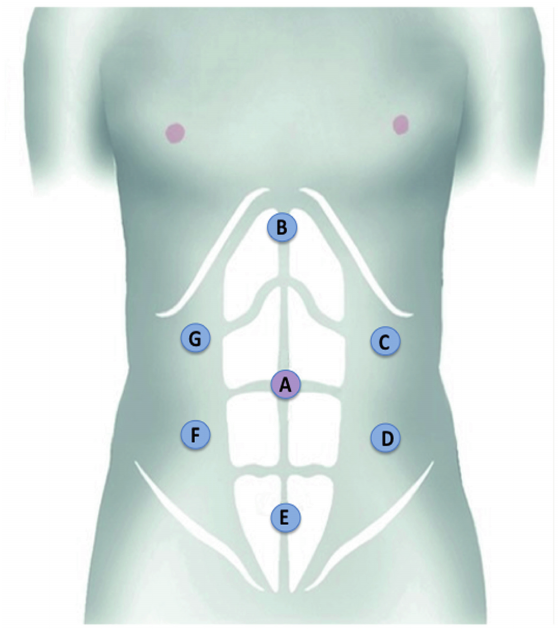
figure 1 – port placement.